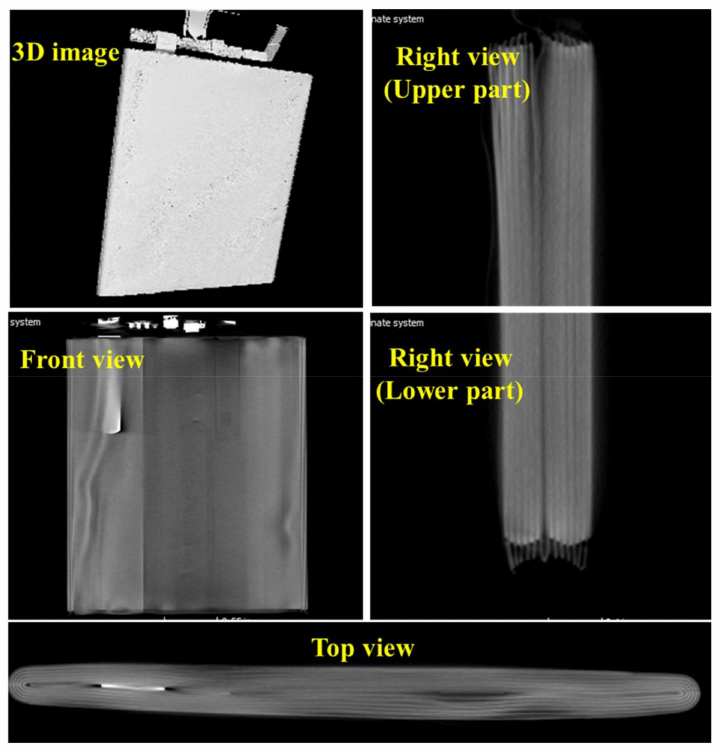
Figure 21. CT scan images of the battery from the used smartphone sample.